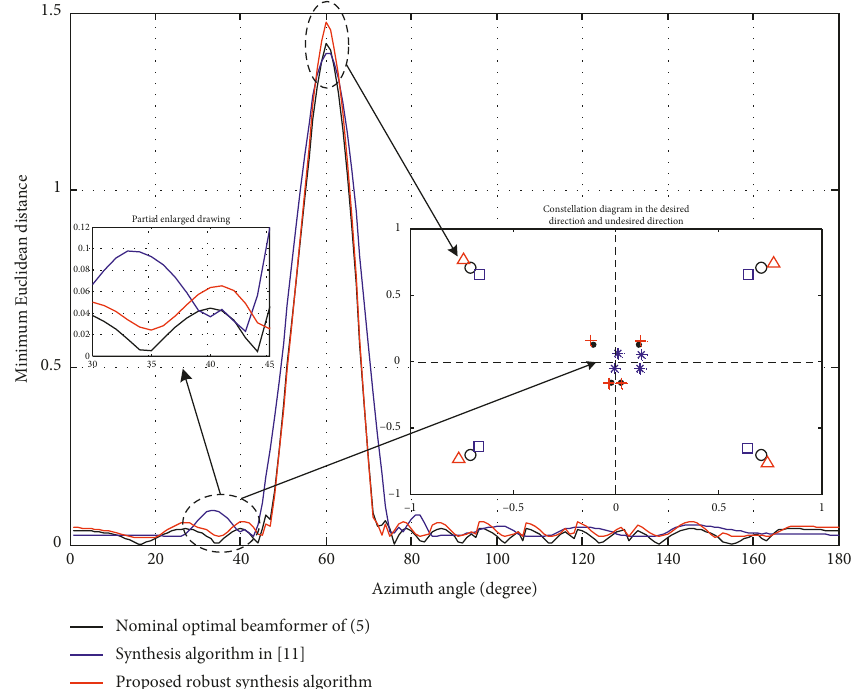
Figure 5: Minimum Euclidean distances of different synthesis algorithms for the DM